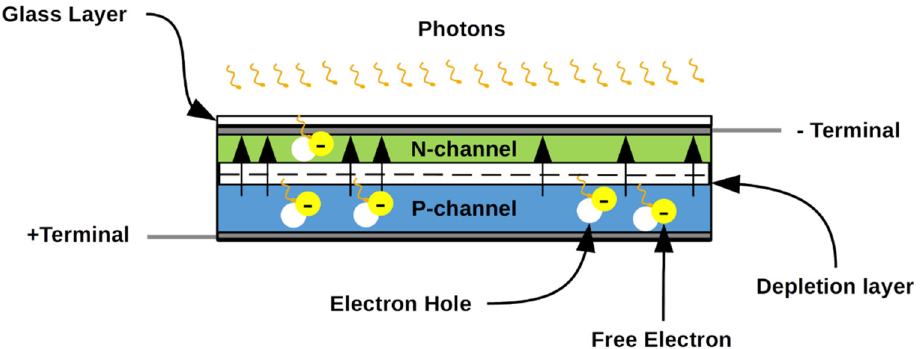
Figure 8. The internal structure of a silicon solar cell. Polycrystalline (P-c) and monocrystalline (M-c) solar cells are the most commonly